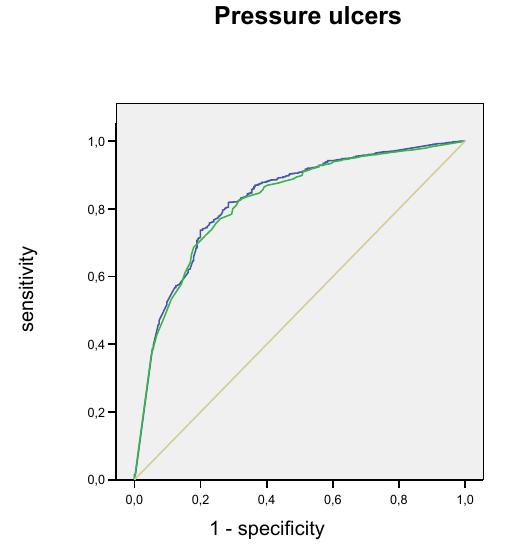
Figure 1. ROC curves for pressure ulcers and falls for CDS sumscore (green) and discriminatory function